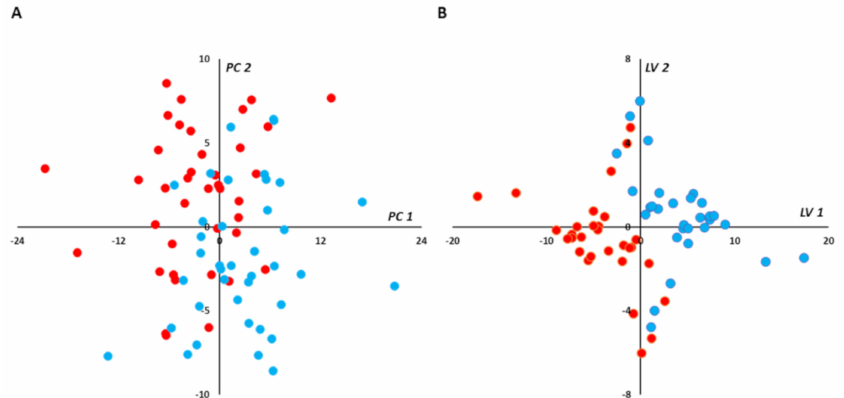
Figure 2. (plasma): Multivariate unsupervised ( A ) and supervised ( B ) scatter plots constructed with plasma samples. ( A ) Principal component analysis (PCA) scatter plot built with all samples (39 in-crisis / 39 out-of-crisis). No spontaneous grouping or outliers were detected in the first principal plan. ( B )Partialleastsquares-discriminantanalysis(PLS-DA)scatterplotbuiltusingmediancoordinates of best models and the 60 training set samples (30 in-crisis / 30 out-of-crisis). A good separation was observed in the plan determined by two latent variables with only two samples misallocated. Legend : PC1,2: principal component 1 and 2, respectively. LV1,2: latent variable 1 and 2, respectively. Red circles correspond to samples drawn during vaso-occlusive crisis and blue circles to samples drawn after the crisis. Principal components and latent variables have no dimension (arbitrary